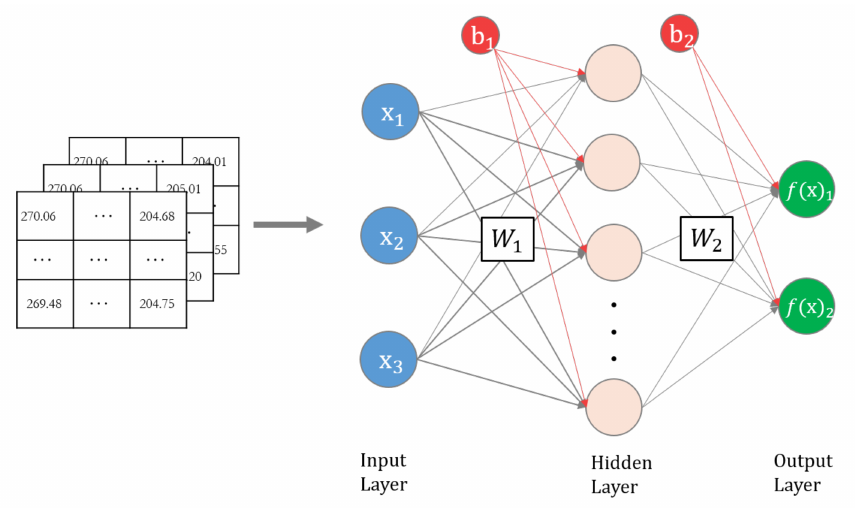
Figure 5. Schematic representation of the NN architecture. The input x 1 , x 2 and x 3 represent, respectively, the simulated BTs at 88.20, 165.50 and 183.31 GHz. For the TIR, the NN architecture has two input nodes that are x 1 and x 2 , representing the BTs at 10.80 and 12.01 µ m,